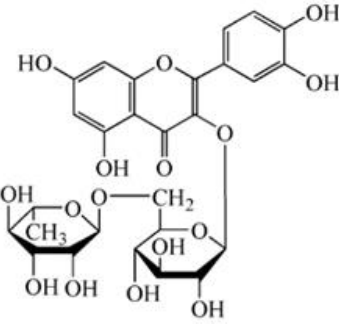
Figure 1. Chemical structural formula of rutin.